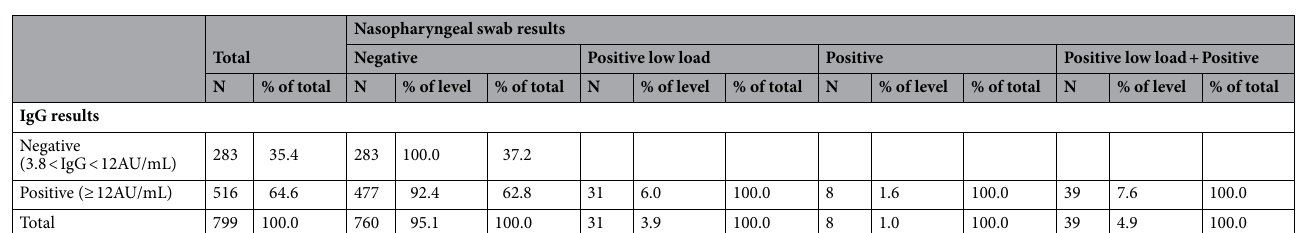
Figure 2. Frequency of IgG positivity (IgG ≥ 12 AU/mL) by age. ( a , b ) Histograms show the number ( a ) and the percentage ( b ) of positive individuals (IgG ≥ 12 AU/mL) divided by age range and sex on the whole population regardless of site (20–30: M, n = 22; F = 88; 31–40: M, n = 31; F, n = 114; 41–50: M, n = 53; F, n = 108; 51–60: M, n = 26; F, n = 56; > 60: M, n = 19; F, n = 6); in b, p -values were determined using Cuzick’s test for trend. p = 0.0374 (total); p = 0.0008 (female); p = 0.1498 (male); p = 0.0024 (interaction).